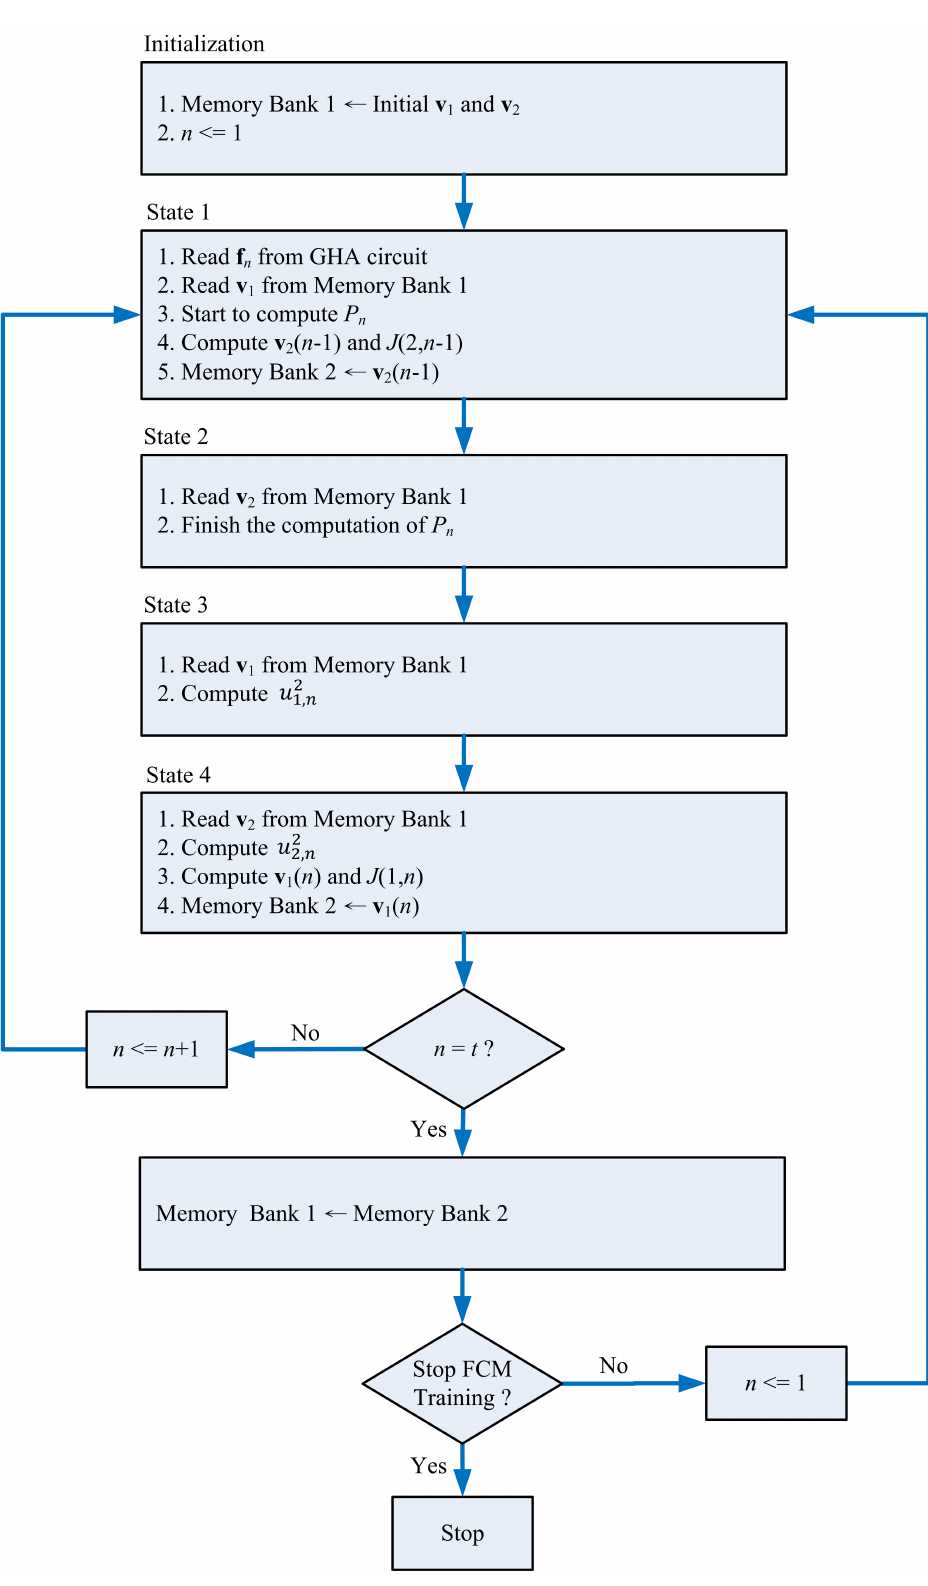
Figure 9. The operations of the FCM circuit for c = 2